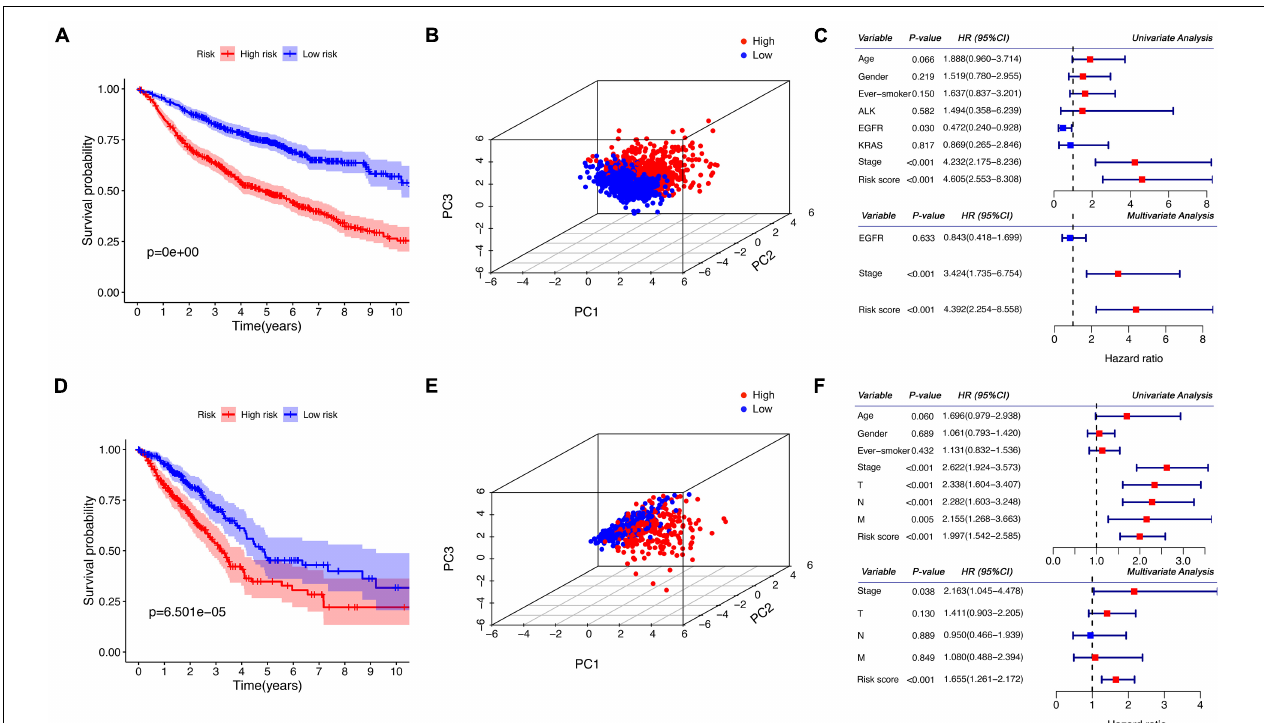
FIGURE 2 | Prognostic analysis of the risk score in the discovery and the validation sets. (A,D) Kaplan–Meier curves for the comparison of the overall survival between the high- and the low-risk group. (B,E) The three-dimensional principal component analysis on the two groups. (C,F) Forest plots for the results of the univariate and multivariate COX regression analyses regarding the overall survival. (A–C) Show the results of the discovery set, while (D–F) show the results of the validation set. PC, principal component; HR, hazard ratio; CI, confidence interval.